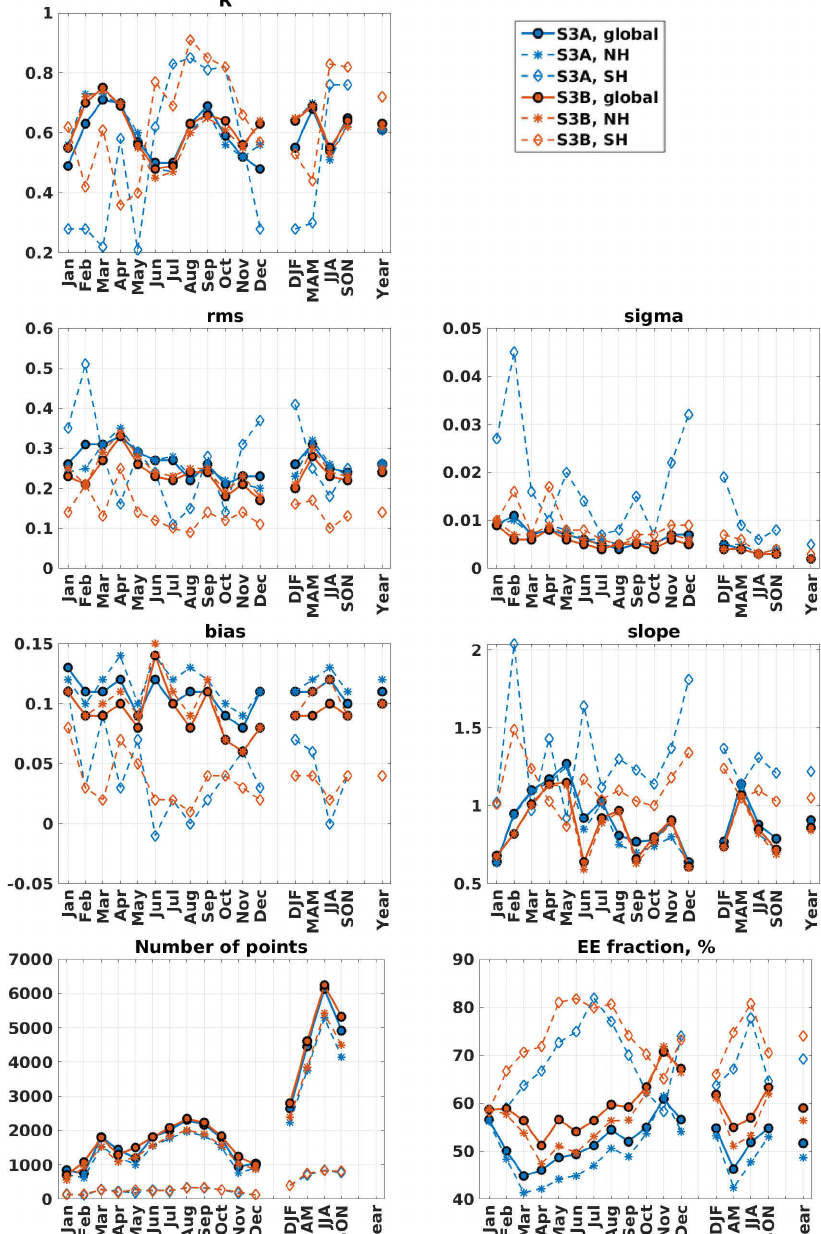
Figure 5. Validation statistics for syAOD 550 aggregated monthly (January, February, and so on), seasonally (DJF, MAM, JJA, SON), and yearly (Year) shown as time series for S3A and S3B for the globe, NH, and